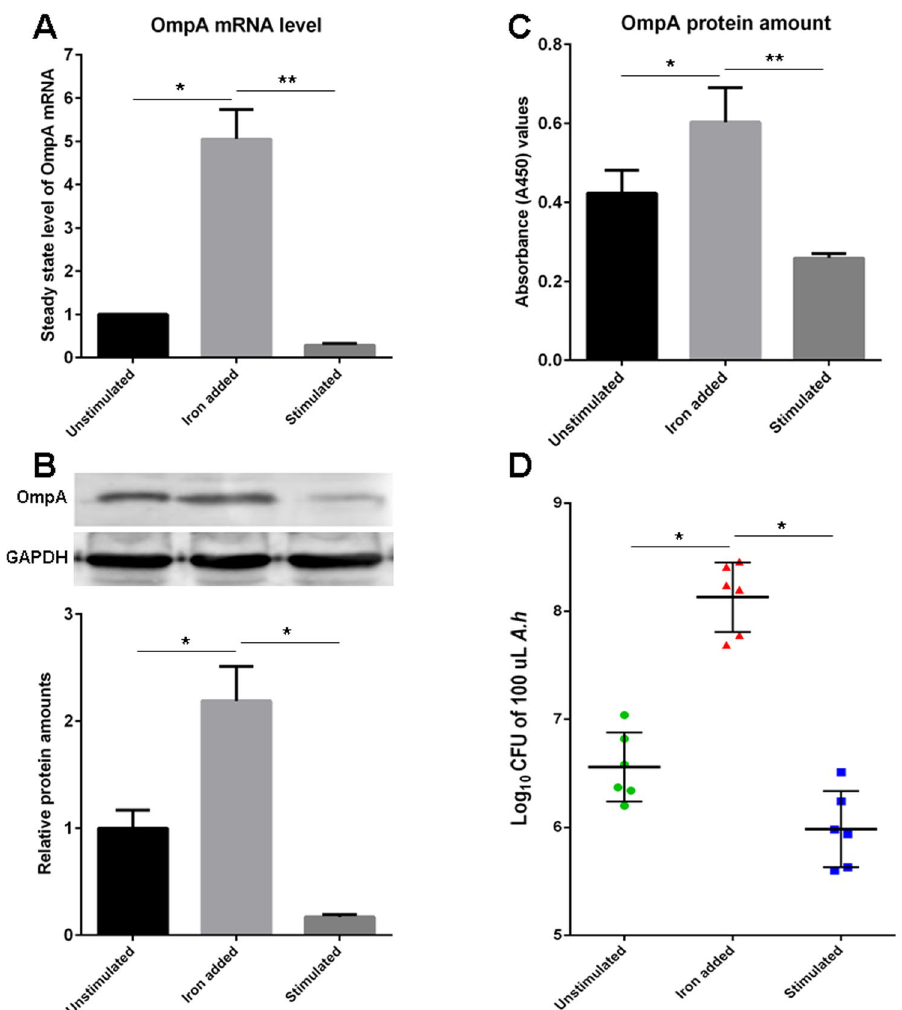
Figure 4. Evaluation of OmpA expression on A. hydrophila cells upon iron-deficient serum stimulation and bacterial susceptibility to complement attack. ( A , B , and C ) The steady state level of OmpA mRNA or the amount of OmpA protein in A. hydrophila cells cultured in the presence of unstimulated serum (Unstimulated), A. hydrophila DNA (1 μ g per fish) stimulated serum plus 10 μ M Fe 2 + supplemented ones (Iron added), and A. hydrophila DNA stimulated serum (Stimulated) was detected by Q-PCR ( A ), Western blot ( B ) and ELISA ( C ). The gray value of the relative signal intensity (OmpA/GAPDH) in Western blot analysis ( B ) was calculated using ImageJ program and depicted in a bar graph. All data are representative of at least three independent experiments. ( D ) Evaluation of the log 10 CFU of 100 μ L A. hydrophila under the attack of guinea pig serum (diluted to 5% as the complement source). A. hydrophila cultured in the presence of differently treated serum samples followed by co-incubation with guinea pig serum. The green round spots (Unstimulated) showed Log 10 CFU of 100 μ L A. hydrophila incubated with normal serum (n = 6), the red triangles (Iron added) showed Log 10 CFU of 100 μ L A. hydrophila incubated with A. hydrophila DNA stimulated serum added with 10 μ M iron (n = 6), and the blue squares (Stimulated) showed Log 10 CFU of 100 μ L A. hydrophila incubated with A. hydrophila DNA stimulated serum (n = 6). The bars in the middle of each group mean average value. The steady state level of OmpA mRNA in A . hydrophila cells was calculated by 2 −ΔΔ CT method normalized to 16 s rRNA. * p < 0.05, ** p < 0.01. The full-length blots are presented in Supplementary Fig.